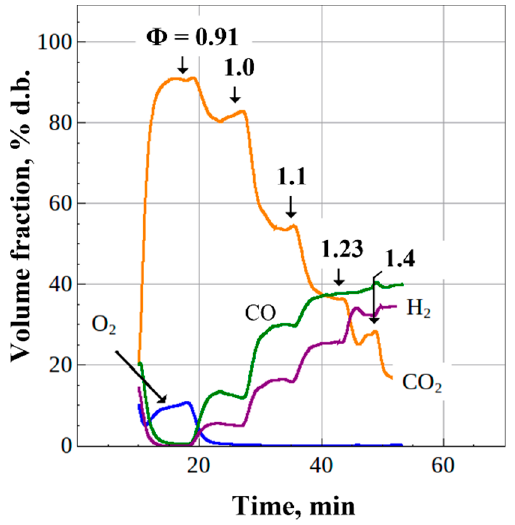
Figure 7. Time history of the composition of cooled dry detonation products of CH 4 /O 2 mixture at stepwise variation of Φ ( f = 1 Hz, P ≈ 0.1 MPa).